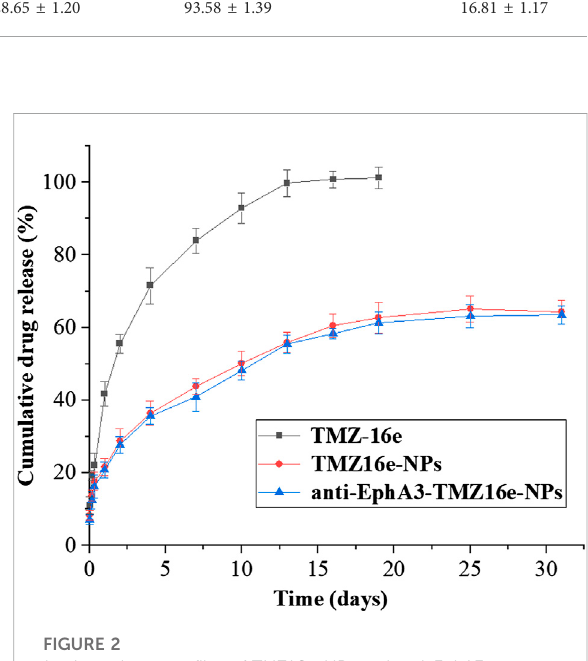
FIGURE 2 In vitro release pro fi les of TMZ16e-NPs and anti-EphA3- TMZ16e-NPs ( n =